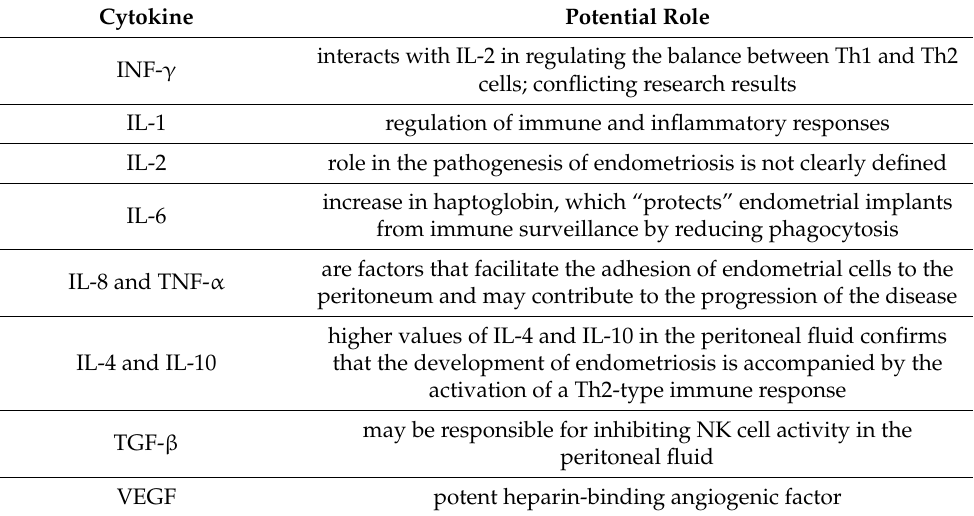
Table 1. The potential role of selected cytokines in the pathogenesis of endometriosis. Cytokine Potential Role interacts with IL-2 in regulating the balance between Th1 and Th2 INF- γ cells; conflicting research results IL-1 regulation of immune and inflammatory responses IL-2 role in the pathogenesis of endometriosis is not clearly defined increase in haptoglobin, which “protects” endometrial implants IL-6 from immune surveillance by reducing phagocytosis are factors that facilitate the adhesion of endometrial cells to the IL-8 and TNF- α peritoneum and may contribute to the progression of the disease higher values of IL-4 and IL-10 in the peritoneal fluid confirms IL-4 and IL-10 that the development of endometriosis is accompanied by the activation of a Th2-type immune response may be responsible for inhibiting NK cell activity in the TGF- β peritoneal fluid VEGF potent heparin-binding angiogenic